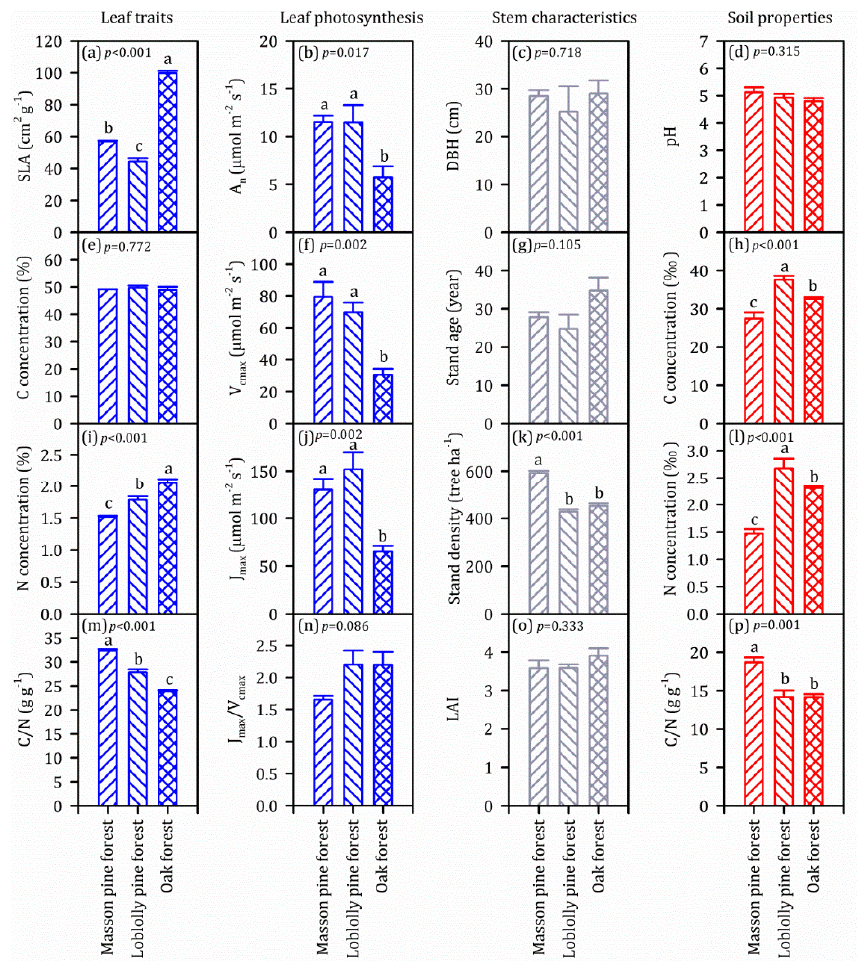
Figure 2. Leaf (blue, ( a , b , e , f , i , j , m , n )), stem (grey, ( c , g , k , o )) and soil (red, ( d , h , l , p )) characteristics for masson pine, loblolly pine and oak forests in subtropical forest ecosystem of central China. SLA (cm g − 1 ), specific leaf area; leaf C concentration (%), leaf carbon concentration; leaf N concentration (%), leaf nitrogen concentration; A n ( μ mol m − 2 s − 1 ), light-saturated net CO 2 assimilation rate; V cmax ( μ mol m − 2 s − 1 ), maximum rate of Rubisco carboxylation; J max ( μ mol m − 2 s − 1 ), maximum rate of photosynthetic electron transport; DBH (cm), diameter at breast height; LAI, leaf area index; soil C concentration (‰), soil carbon concentration; soil N concentration (‰), soil nitrogen concentration. Values are means ± SE ( n = 4). Different lowercases represent significant differences among forest stands ( p < 0.05).